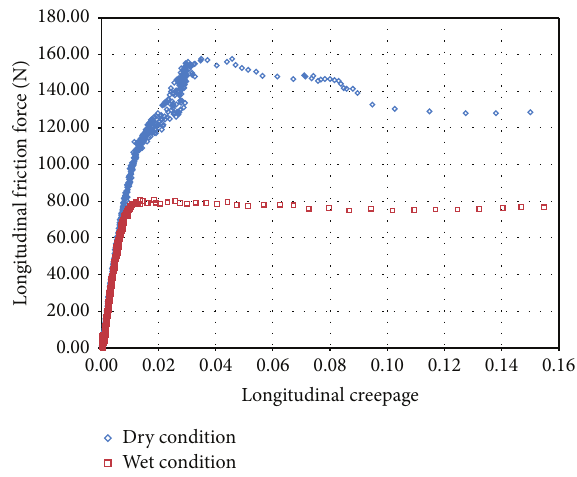
Figure 5: Creepage curve in wet and dry conditions considering a reference speed of 1000rpm and a vertical load of 37 kg on each wheel.